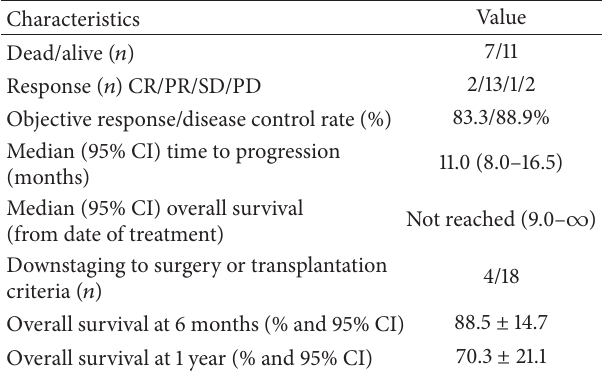
Table 3: Treatment outcomes ( 𝑛 = 18